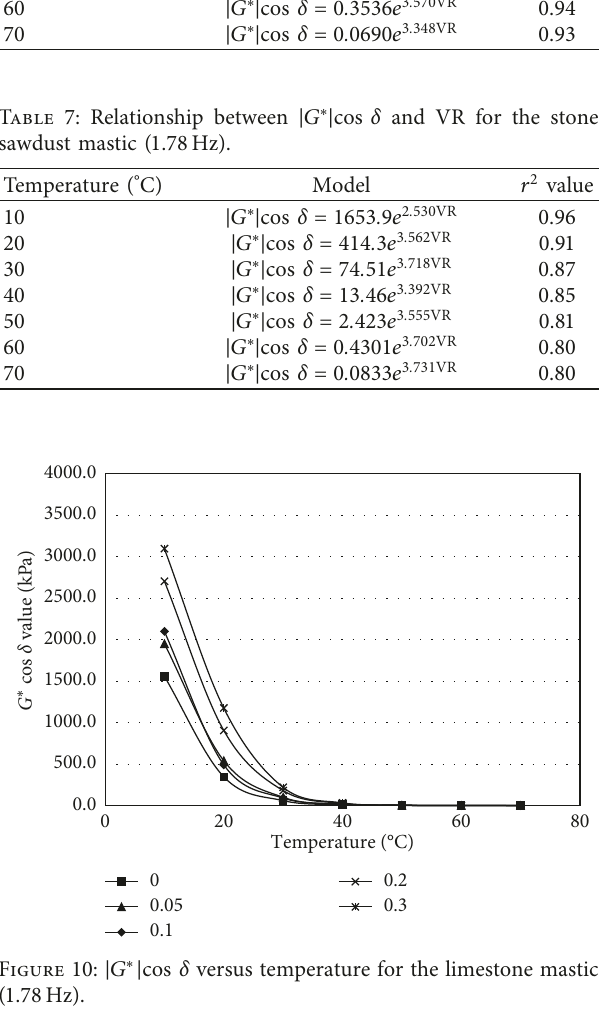
G cos δ versus temperature for the limestone mastic | | ∗